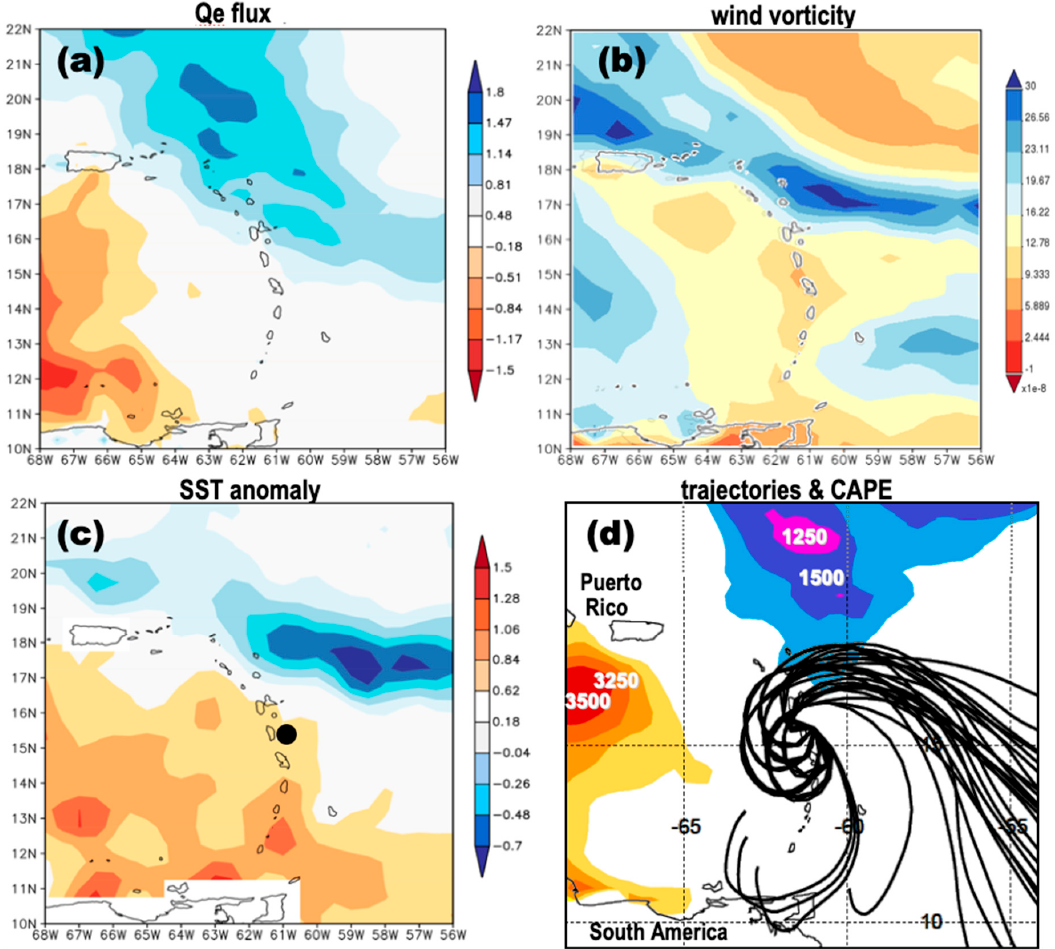
Figure 3. Pre-hurricane 5–15 September 2017 averaged: ( a ) Latent heat flux anomaly (W m –2 ), ( b ) 925 hPa wind potential vorticity (PVU), and ( c ) satellite SST anomalies (°C). ( d ) Back-trajectories arriving at 500 m, 15.5 N, 61 W (dot in c) in a 36 h period, from 18Z 17 September to 06Z 19 September 2017; and CAPE (shaded, J/kg).